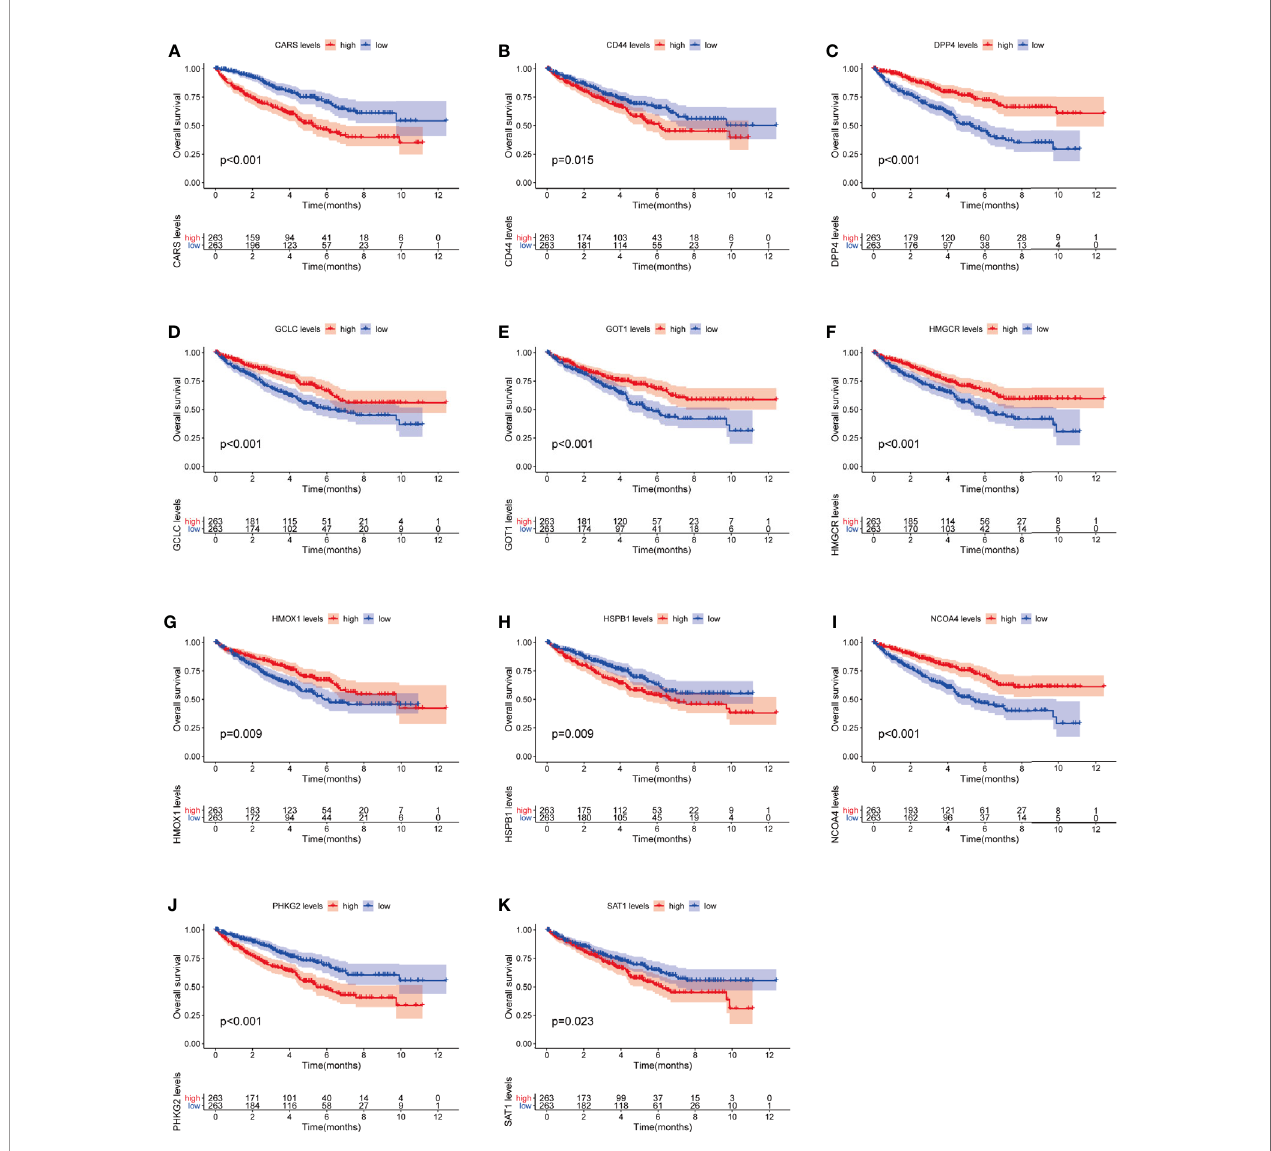
FIGURE 5 | Kaplan – Meier survival curve analysis veri fi ed the prognostic value of ferroptosis-related genes in ccRCC. (A) CARS, (B) CD44, (C) DPP4, (D) GCLC, (E) GPT1, (F) HMGCR, (G) HMOX1, (H) HSPB1, (I) NCOA4, (J) PHKG2, (K)